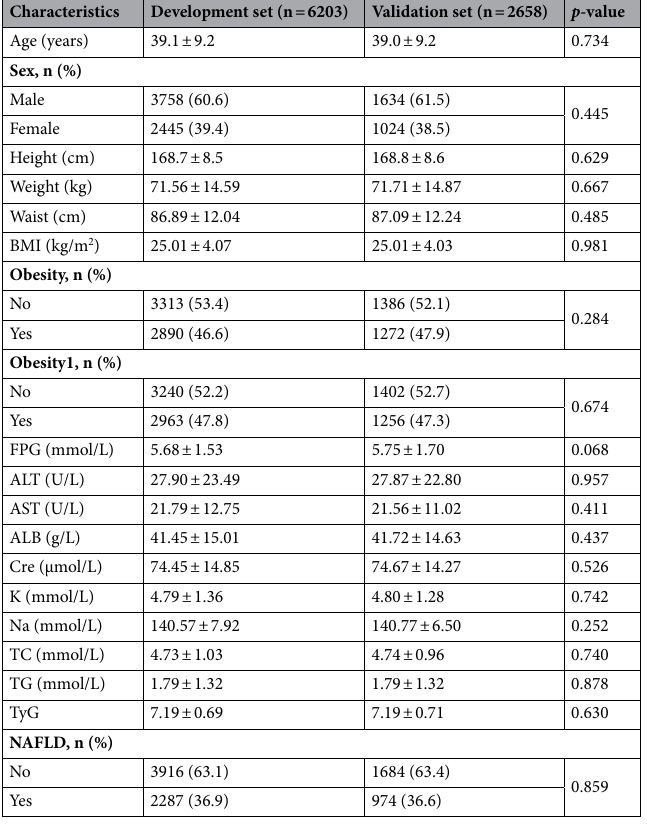
Table 1. Characteristics of the development set and validation set. Obesity: BMI ≥ 25.0 kg/m 2 ; obesity1: